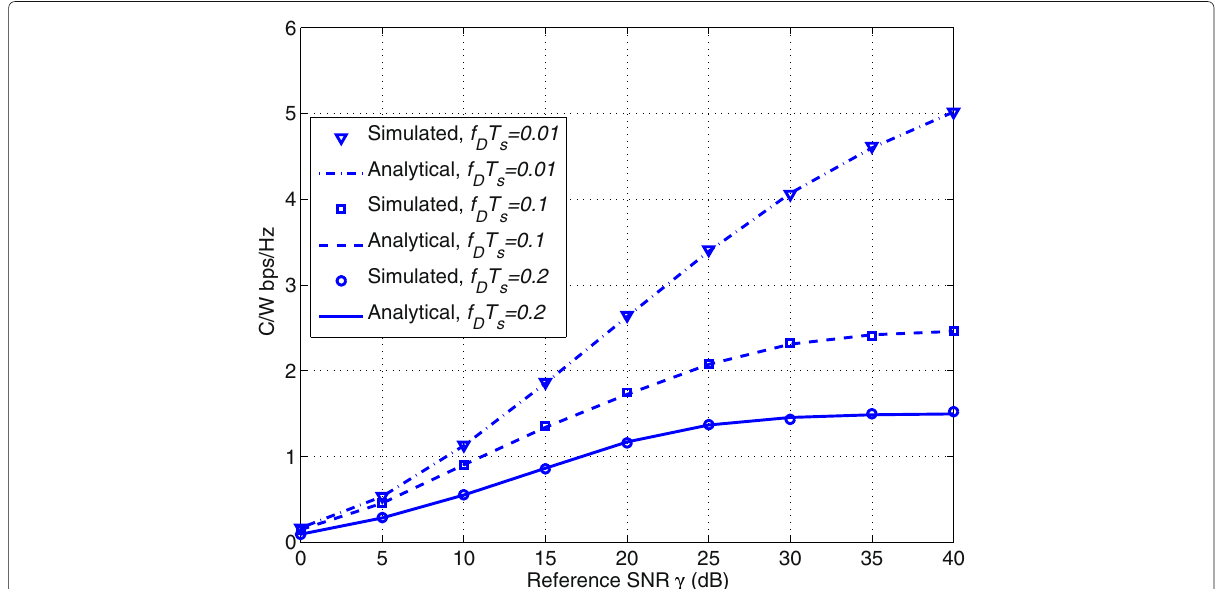
Fig. 7 Spectral efficiency lower bound for systems with different maximum normalized Doppler spread ( N = 4 and x = 200)